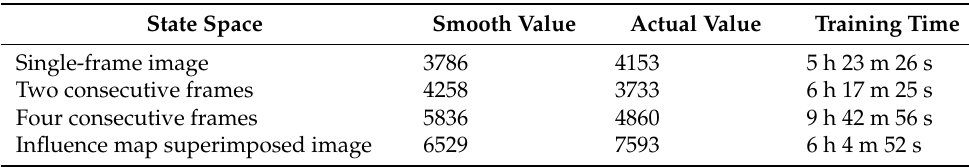
Table 7. Ordinate comparison of four training scores at 1.4 M gradient descent.